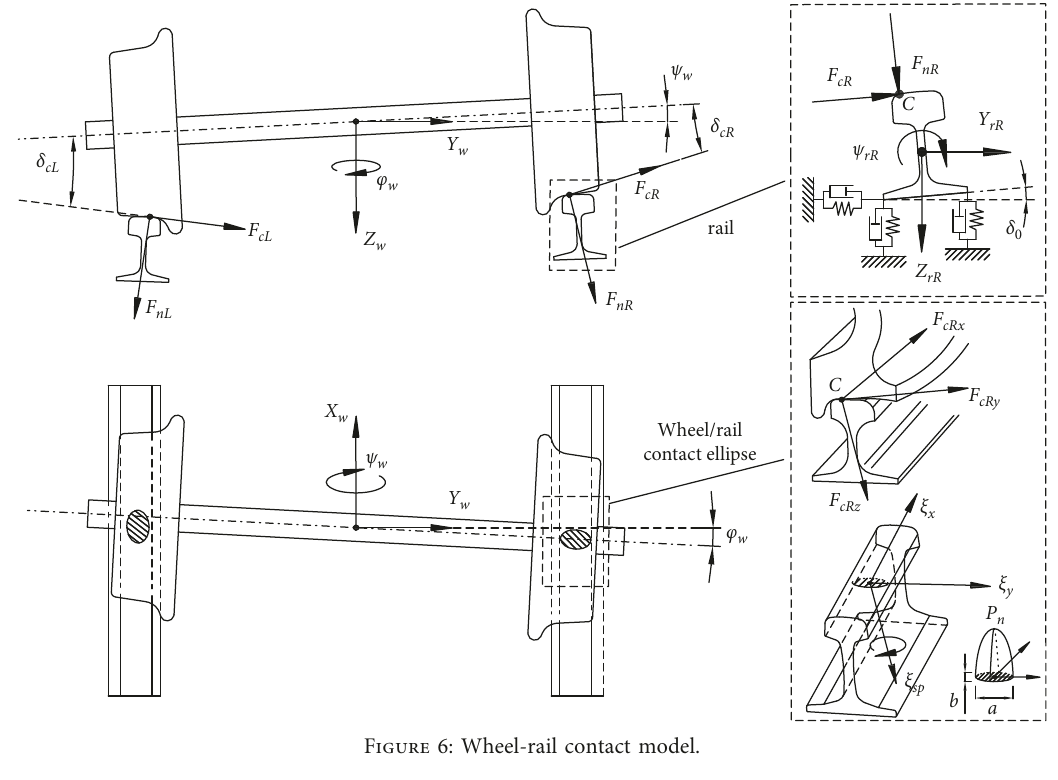
Figure 6: Wheel-rail contact model.